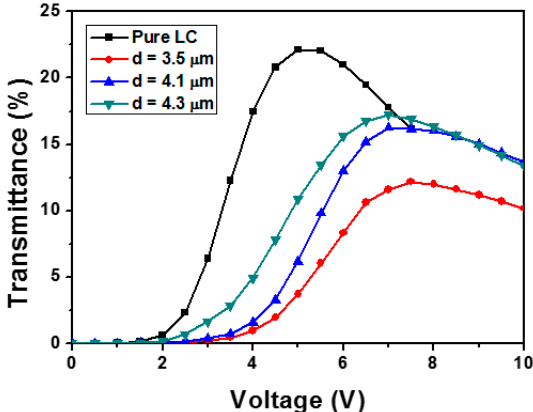
Figure 4. Normalized V-T curves of IPS cells fabricated by curing 1 and 3 wt% of RM at 20 °C, and 1 wt% of RM at − 20 °C.